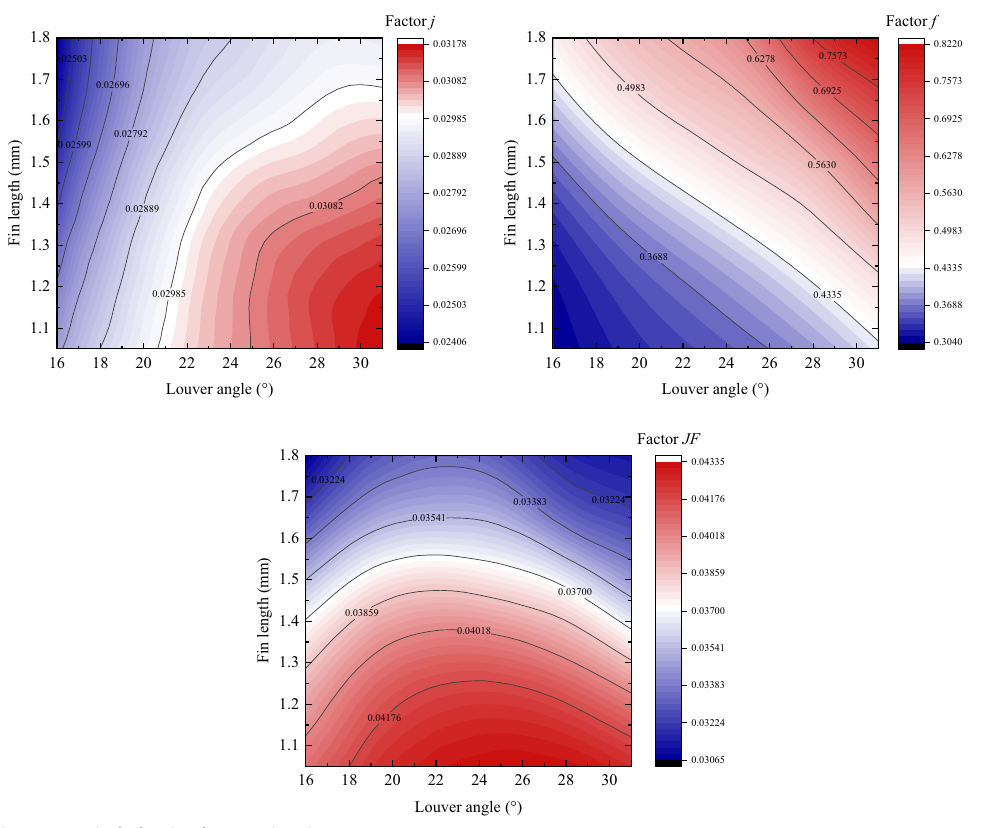
Figure 17 Change trend of j, f and JF factors when louver spacing is 1.3